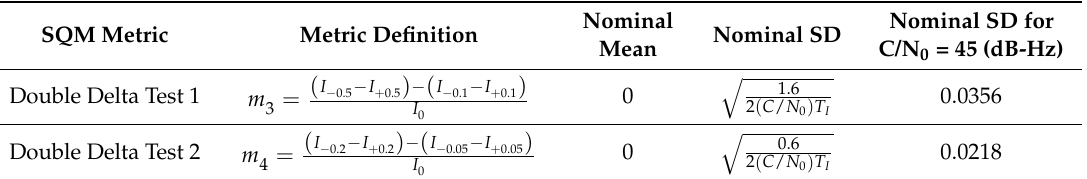
Table 2. Double-Delta tests for BPSK(1) signaling.